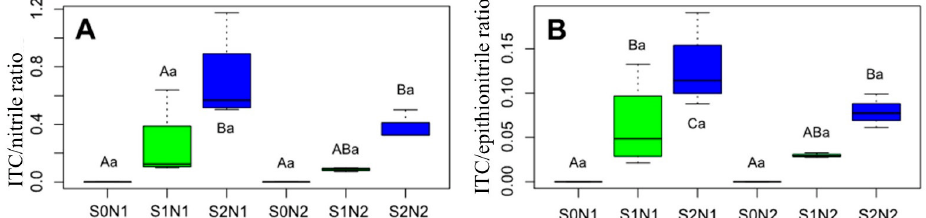
Fig. 7: ITC/nitrile ratio (A) and ITC/epithionitrile ratio (B) in pak choi plants fertilized with varied N and S supply. Lower- and uppercase letters indicate significant di ference (p<0.05) between means owing to the effect of N and S supply respectively, S0 = 0 g S, S1 = 0.06 g S, S2 = 0.3 g S, N1 = 0.75 g N, N2 = 1.5 g